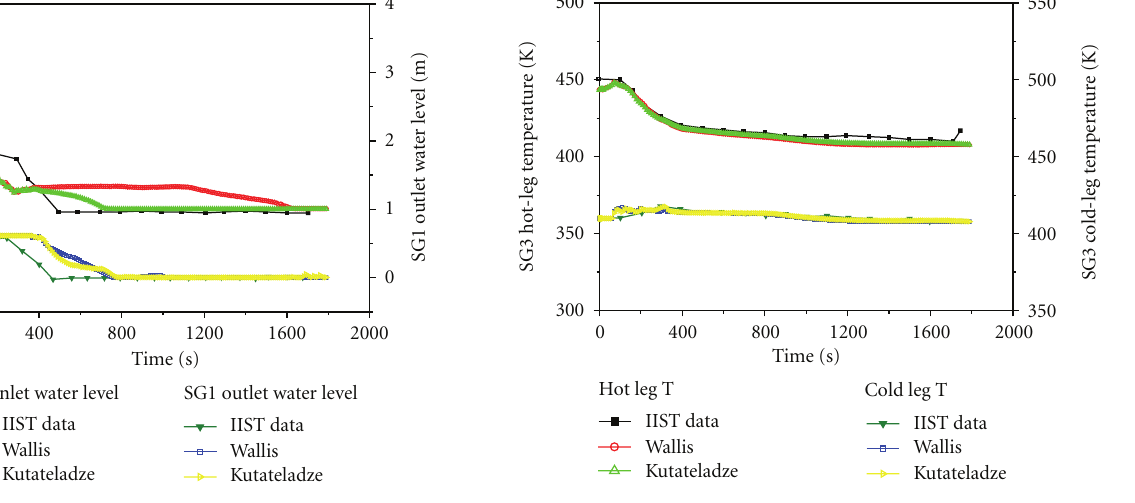
Figure 8: The comparison of SG3 hot leg and cold leg temperature among Wallis form, Kutateladze form, and IIST data.